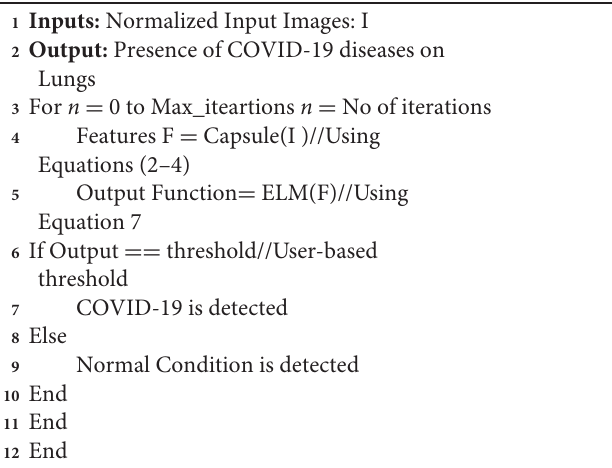
Algorithm 1: Pseudo code for the proposed ensembled